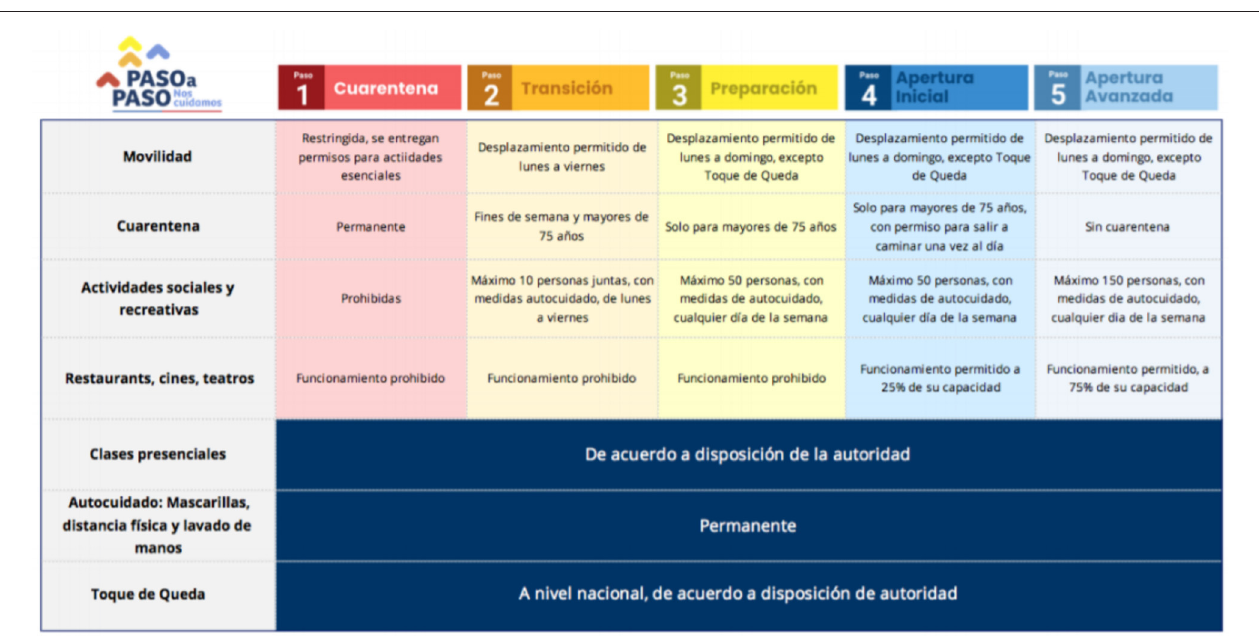
FIGURE 1 | Screenshot of the Step-by-Step plan outlining mobility restrictions in Chile during the pandemic—in Spanish. Source: MINSAL (2020) (Ministry of Health).